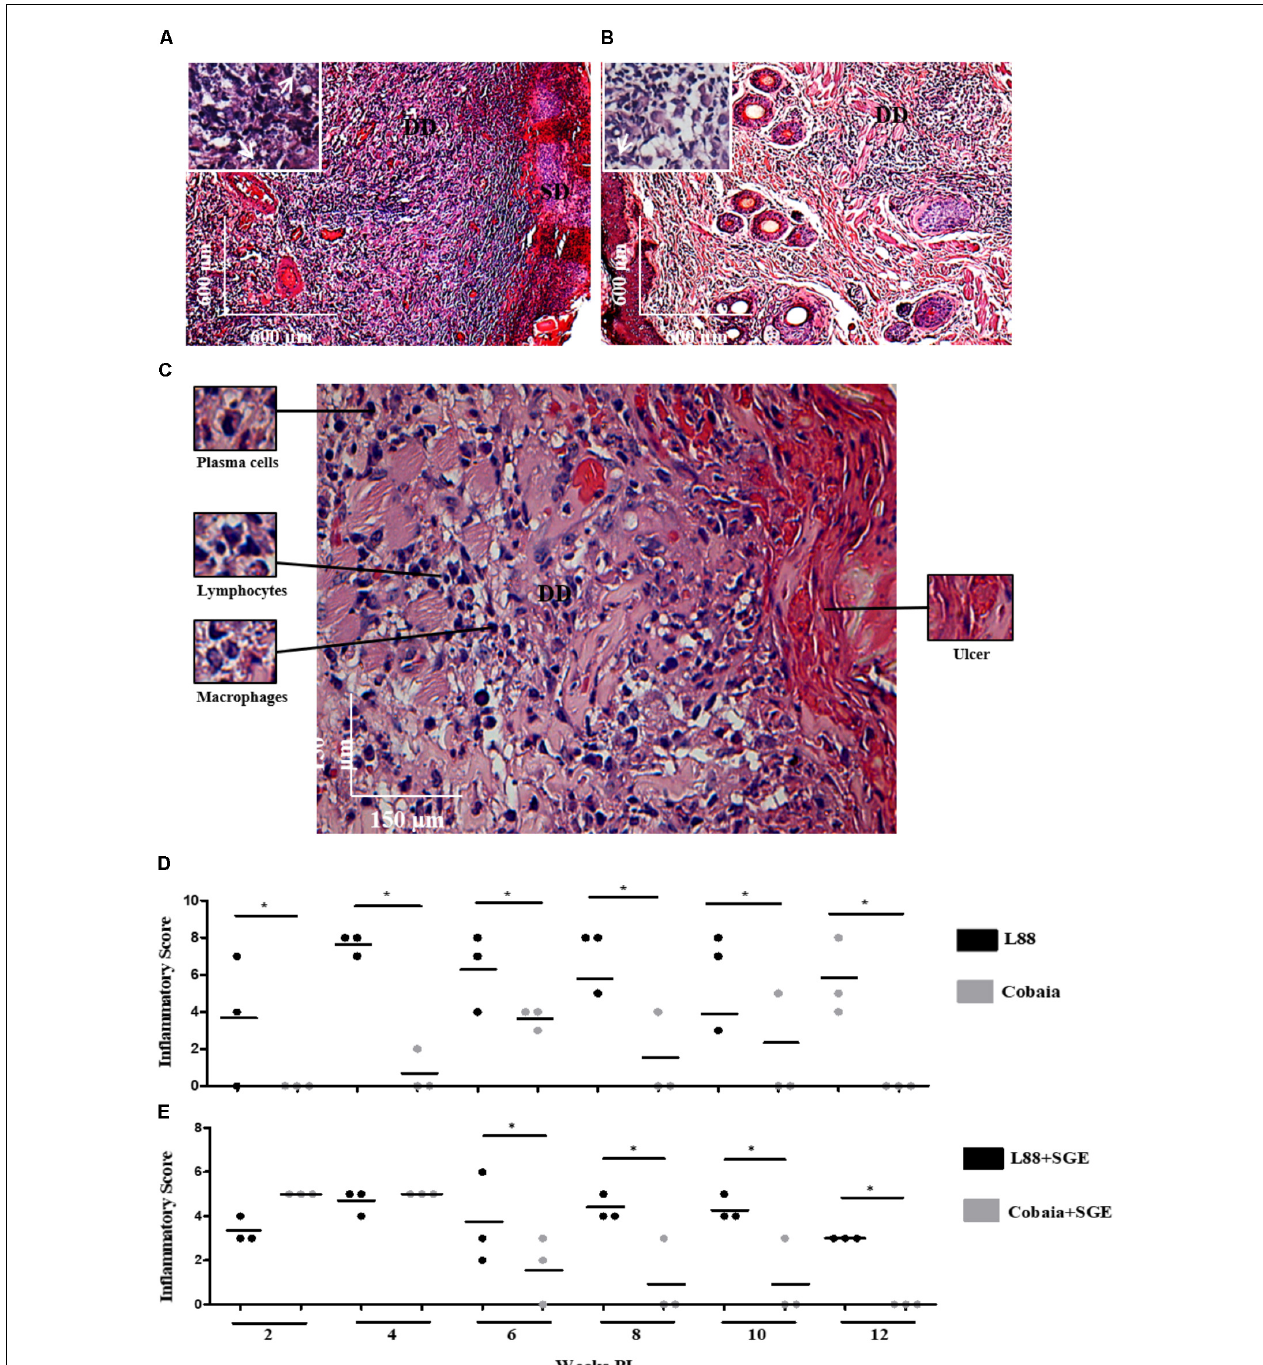
FIGURE 2 | Histopathology (HE) of C. porcellus infected with L. enriettii (L88 and Cobaia) strains in the absence of salivary gland extract (SGE). (A) L88-infected animals exhibited an intense and diffuse chronic inflammatory process. Lower magnification showing a presence of an intense mononuclear exudate throughout the dermis. Epithelial ruptures with crust formation were a consequence of proteinaceous exudate. Amplified section on the left showing amastigote forms of Leishmania inside macrophages (arrows). (B) Cobaia-infected animals in lower magnification showing a discrete focal chronic inflammatory reaction. Amplified section on the left showing intracellular amastigote forms inside macrophages (arrow). (C) Histological section of the nasal region of L88-infected C. porcellus in higher magnification showing an intense and diffuse chronic inflammatory reaction. Amplified sections on the left side showing plasma cells, lymphocytes, and macrophages. On the right side, an epithelial rupture with crust formation (ulcer) as a consequence of proteinaceous exudate. Inflammatory Scores of C. porcellus infected with L. enriettii (L88 and Cobaia) strains in the absence (D) and presence (E) of SGE at 2, 4, 6, 8, 10 and 12 weeks PI. DD, deep dermis; SD, superficial dermis. Asterisks indicate statistical significance between groups at p <